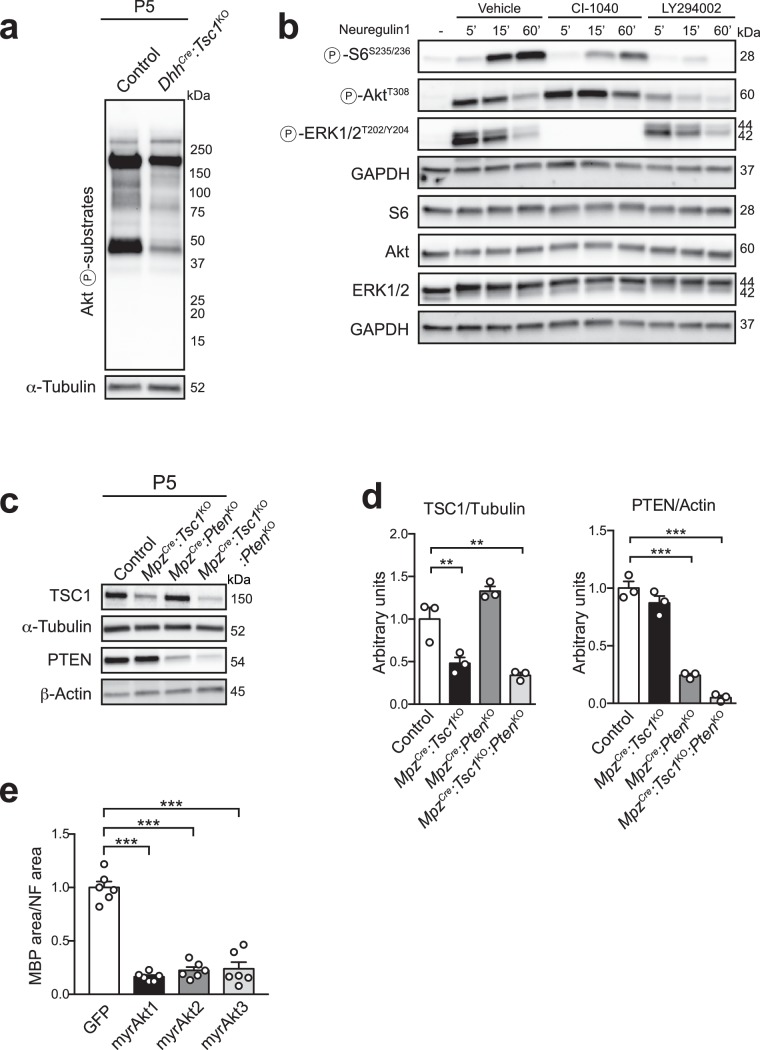
Reciprocal interactions between the mTORC1 pathway and the PI3K-Akt pathway in SCs.(a) Western blot analysis for proteins with a phosphorylated consensus motif for Akt phosphorylation (RXXS/T) from P5 control and DhhCre:Tsc1KO nerves (n = 3 mice/genotype). A representative blot is shown. (b) Western blot analysis, rat SCs treated with neuregulin-1 in the presence of vehicle (DMSO), 5 μM CI-1040 (MEK inhibitor), or 20 μM LY294002 (PI3K inhibitor). Two independent experiments performed, one representative experiment shown. (c) Western blot analysis, sciatic nerve lysates from P5 control, MpzCre:Tsc1KO, MpzCre:PtenKO, and MpzCre:Tsc1KO:PtenKO mice (n = 3 mice/genotype). (d) Quantification referring to c. Bar height: mean; error bars: s.e.m. Control average is set to 1 (n = 3 mice/genotype, including the biological replicates representatively shown in c, one-way ANOVA with Dunnett’s multiple comparisons test; TSC1/Tubulin, F(3,8) = 30.56, p<0.0001, pcontrol vs TSC1KO = 0.0057, pcontrol vs doubleKO = 0.0013; PTEN/Actin, F(3,8) = 115.4, p<0.0001, pcontrol vs PTENKO = 0.0001, pcontrol vs doubleKO = 0.0001). (e) Quantification referring to Figure 2h. Data are expressed as average ratio between the MBP-positive area and the corresponding NF-positive area. The average of GFP-infected controls is set to 1. Bar height: mean; error bars: s.e.m. (n = 6 coverslips/condition, one-way ANOVA with Dunnett’s multiple comparisons test, F(3,20) = 76, p<0.0001; pGFP vs Akt1 = 0.0001, pGFP vs Akt2 = 0.0001, pGFP vs Akt3 = 0.0001). **p<0.01, ***p<0.001.